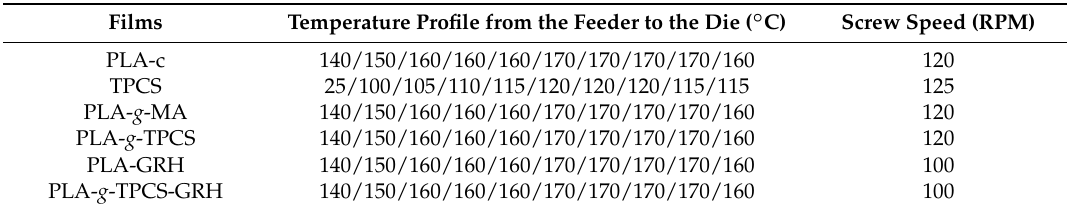
Table 1. Conditions of processing of master batches in the twin-screw extruder.